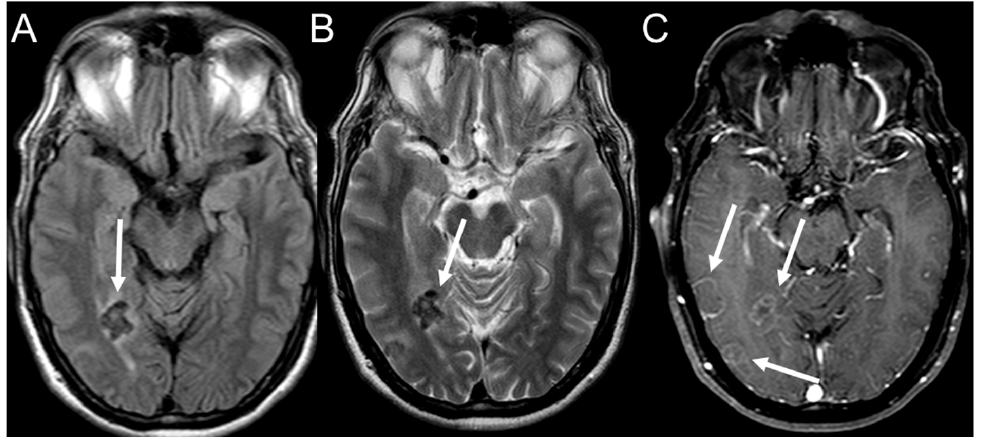
Figure 7. Magnetic resonance imaging showing a hypointense lesion on fluid-attenuated inversion recovery (FLAIR) ( A ) and T2-weighted imaging (T2WI) ( B ), with an annular enhancement on T1 post-contrast ( C ) located in the right occipital and temporal lobes.